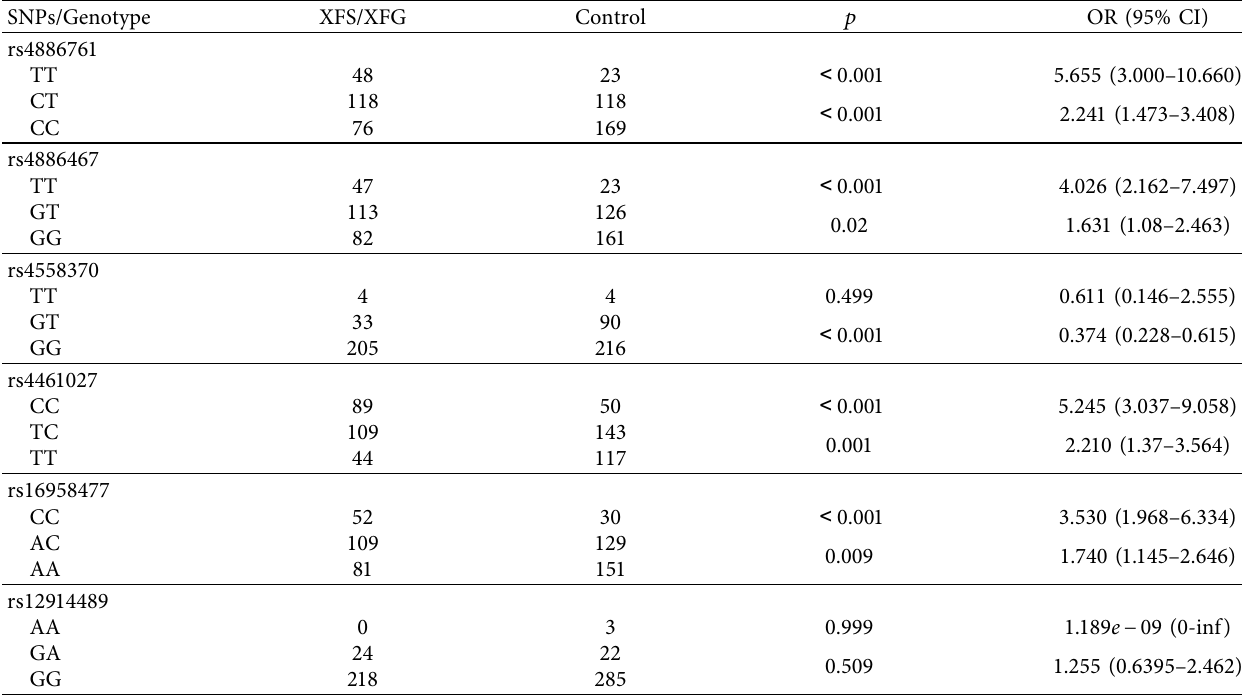
Table 5: Associations of various genotypes with the SNPs.